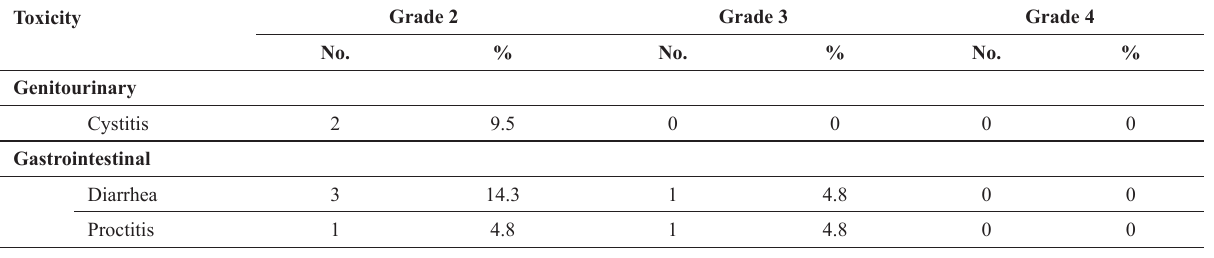
table 2: Frequency of acute radiation